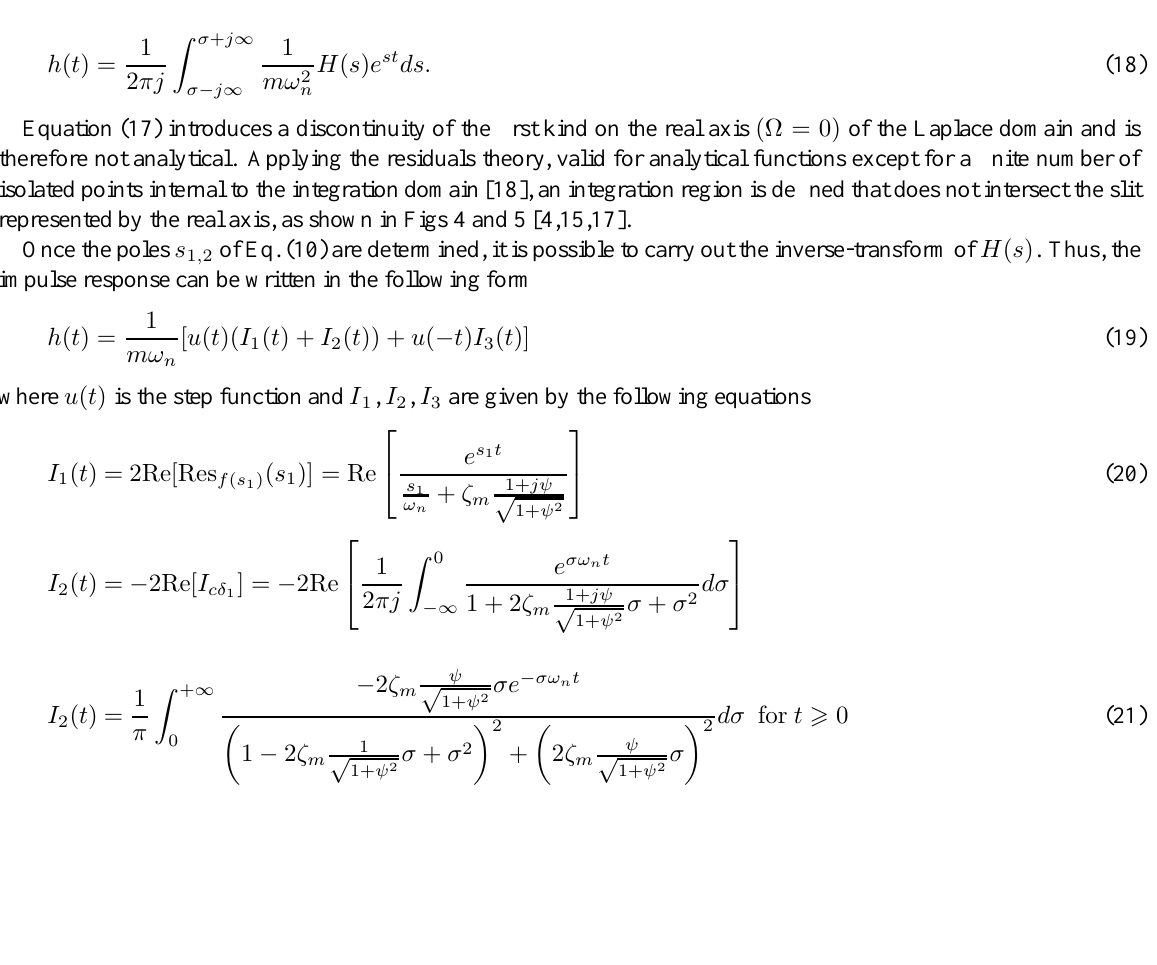
Fig. 4. Integration region of the Laplace domain for t (cid:1) 0